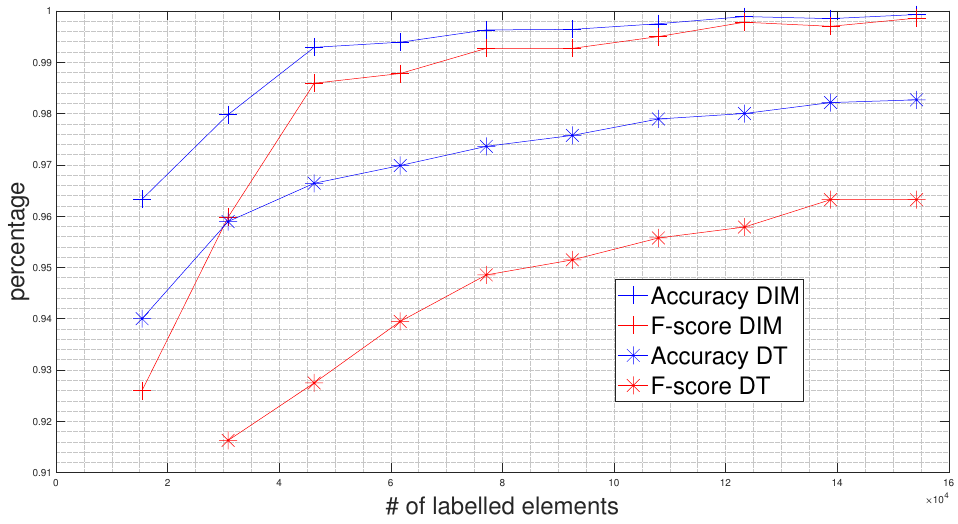
Figure 7. Accuracy and F-score of Deep Infomax (DIM) method and Decision Tree (DT) [11]